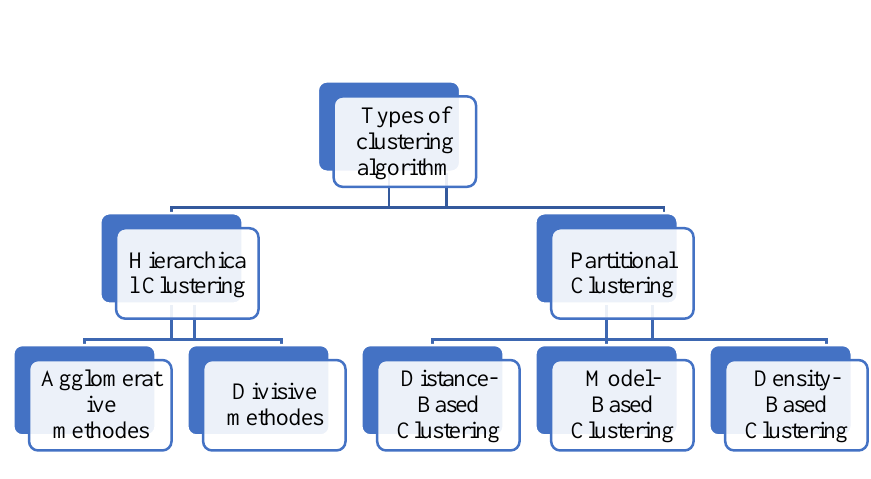
Figure 1. Types of clustering algorithms (Saxena et al.,